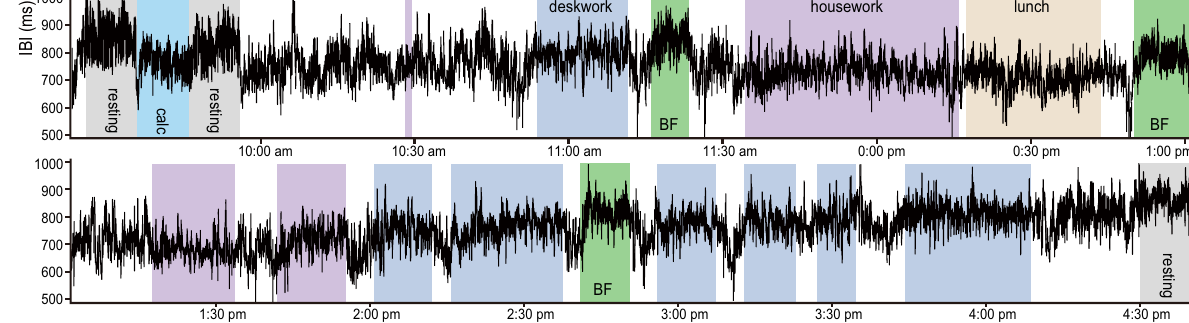
Fig. 1 Maternal IBI transition during her daily home activities. One mother’s IBI plot during her natural daily activities at home for about 7 h. At the beginning and end of the experiment, the mother performed resting, math calculation and resting for 10 min each while seated. Shaded areas indicate her behavioral tasks of resting (grey), calculation (light blue), deskwork (dark blue), breastfeeding ( BF , green), housework (purple), and lunch